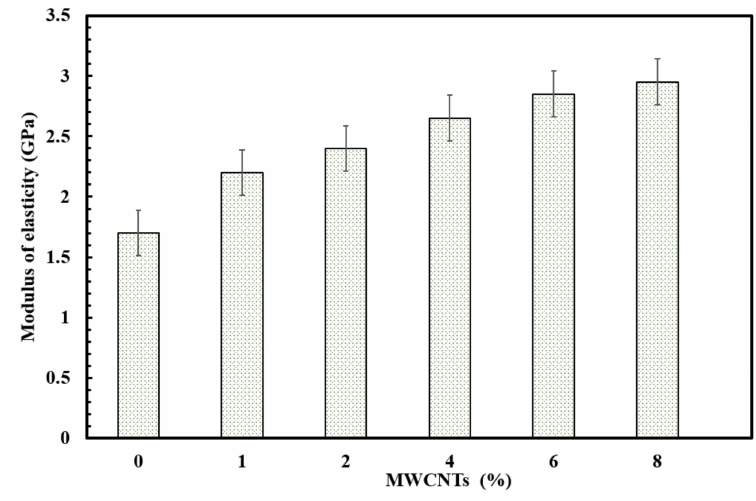
Figure 4. Effect of MWCNTs on modulus of elasticity of PP-GF composites.